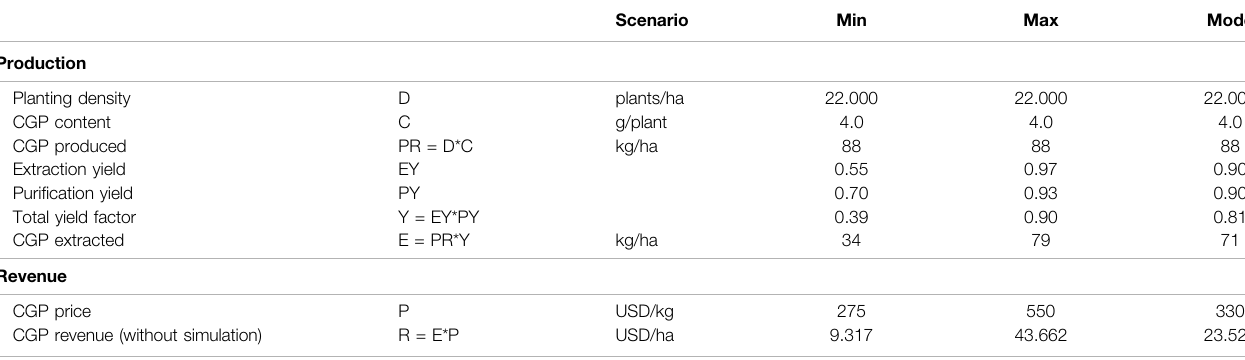
TABLE 2 | Calculated CGP production and revenue. The input values for the Monte Carlo simulation are